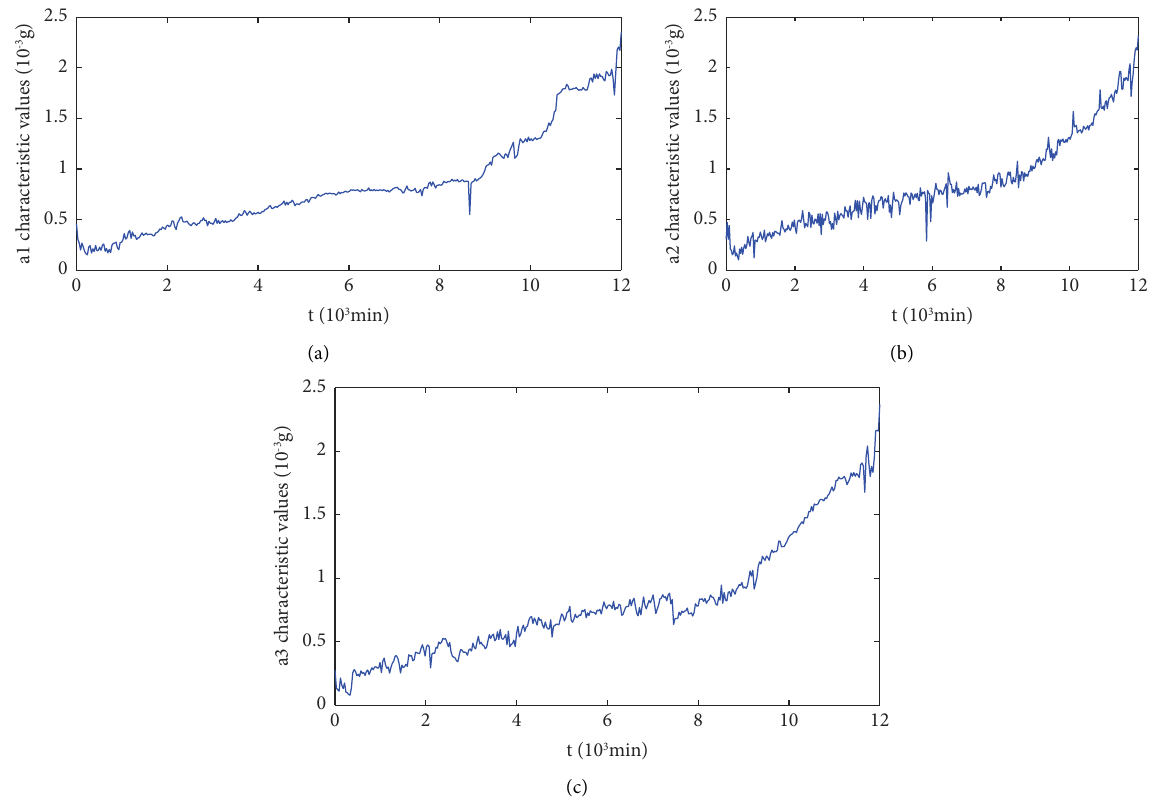
Figure 3: Feature extraction. (a) a1 characteristic value. (b) a2 characteristic value. (c) a3 characteristic value.